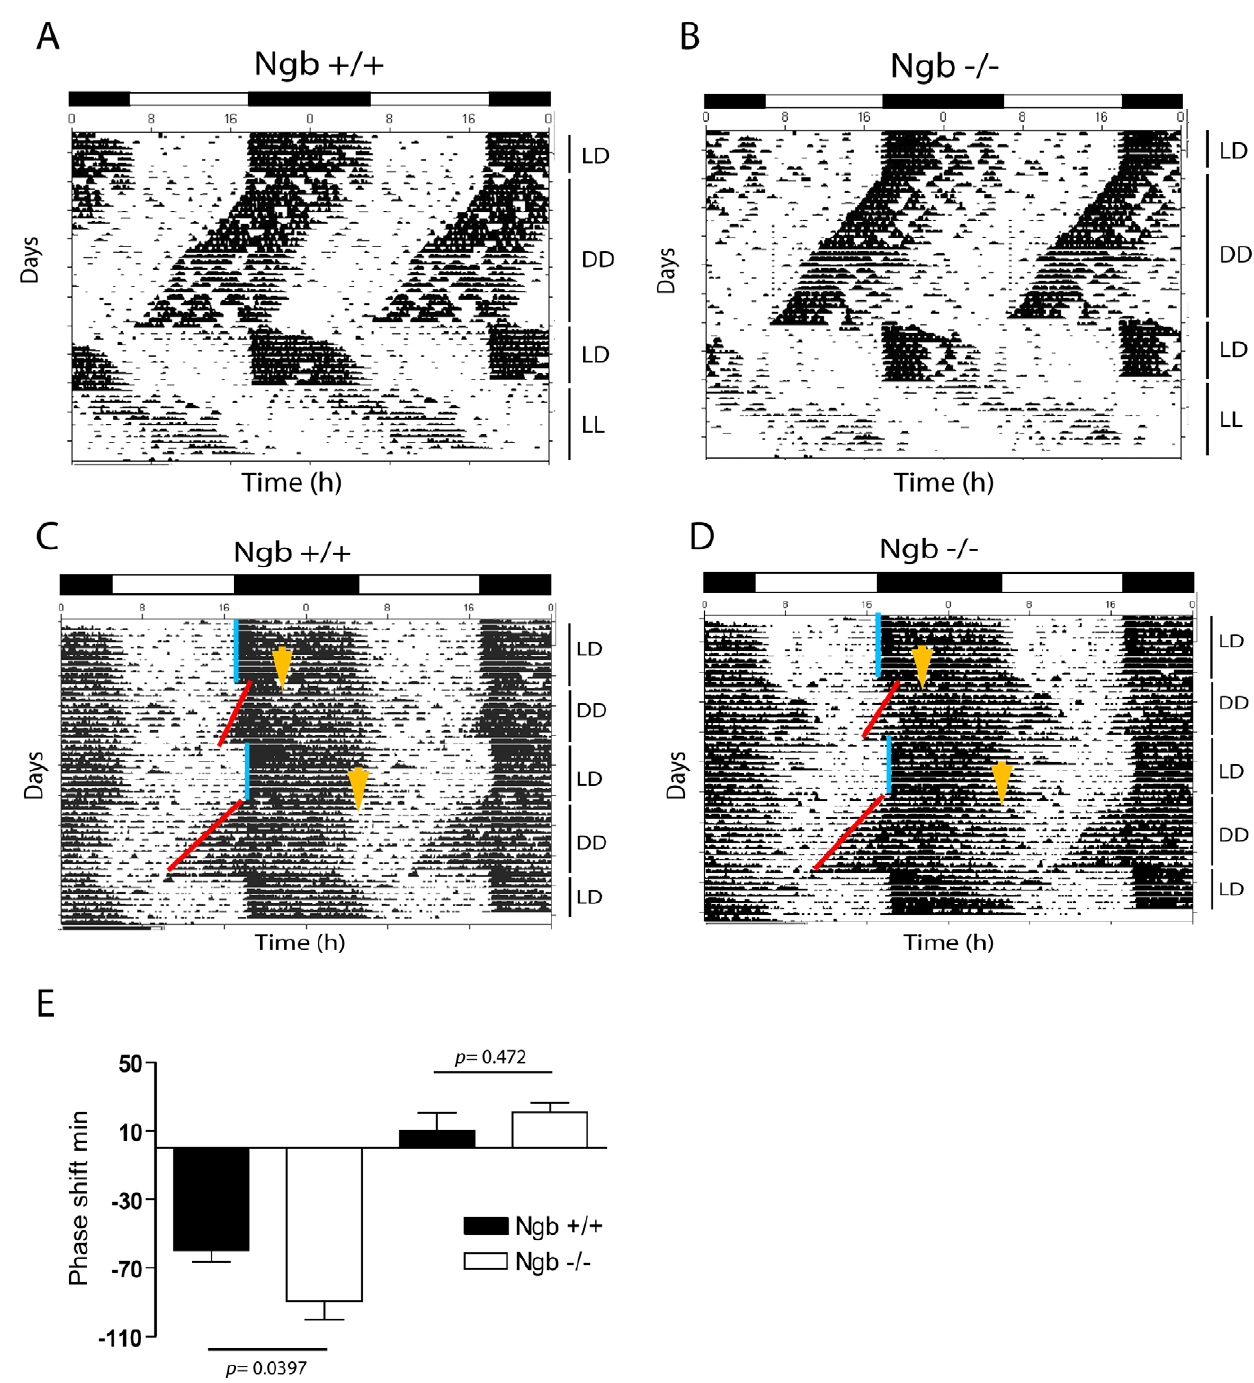
Figure 2. Running wheel activity in Ngb deficient mice. A . Double plot actogram representing running wheel activity of Ngb wild type ( A ) and Ngb deficient mice ( B ) during a period of 12:12 h LD cycle followed by constant darkness (DD), re-entrainment to a new LD cycle followed by a period of constant light (LL). Both groups behave similarly and have a TAU not significantly different between the two genotypes. C and D . Light stimulation at ZT16 and ZT22 result in phase delays and phase advance, respectively which is illustrated in wild type animals ( C ) and in Ngb deficient mice ( D ). Ngb deficient mice display a significantly larger phase delay at ZT16 as shown in E. Yellow arrows indicates the time of the light pulse. Error bars=S.E.M., Mann Whitney-U test. doi:10.1371/journal.pone.0034462.g002 light stimulation with a significant increase in Per1 and Fos mRNA induced expression of Per1 and Fos (another light-responsive gene expression in the SCN using two independent methods (real time in the SCN [21]) genes in wt and Ngb 2 / 2 mice at early subjective night where the Ngb deficient mice demonstrated a larger phase RT-PCR and quantitative ISH). In relation to wt, light induced a delay compared to wild type mice. Both genotypes responded to slight but significantly higher expression of Per1 in Ngb 2 / 2 mice as